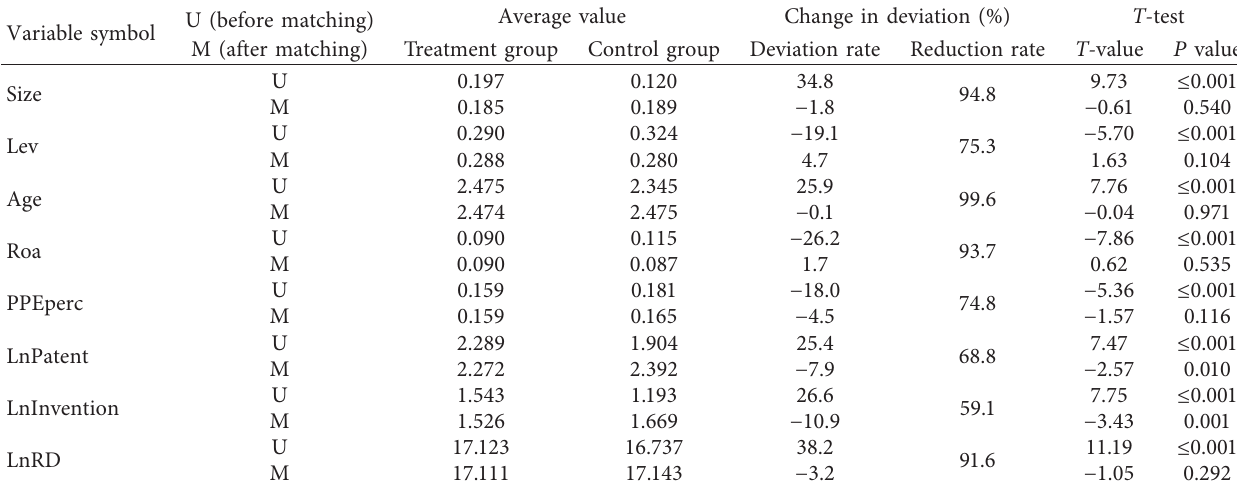
Table 1: Change in deviations for the treatment and control groups after matching. U (before Variable symbol